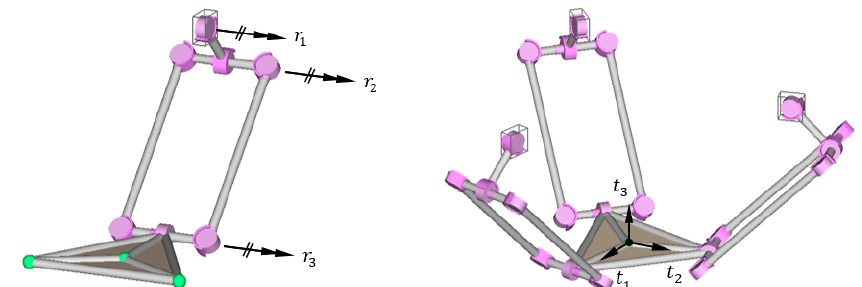
Figure 1. Delta Robot (three translations t 1 , t 2 and t 3